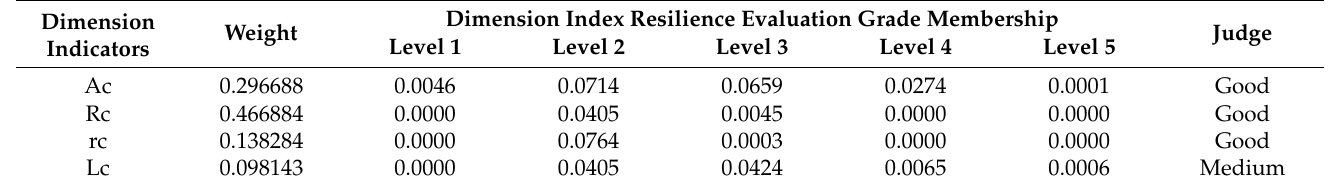
Table 9. Deep foundation pit construction safety system resilience evaluation dimension index grade membership.